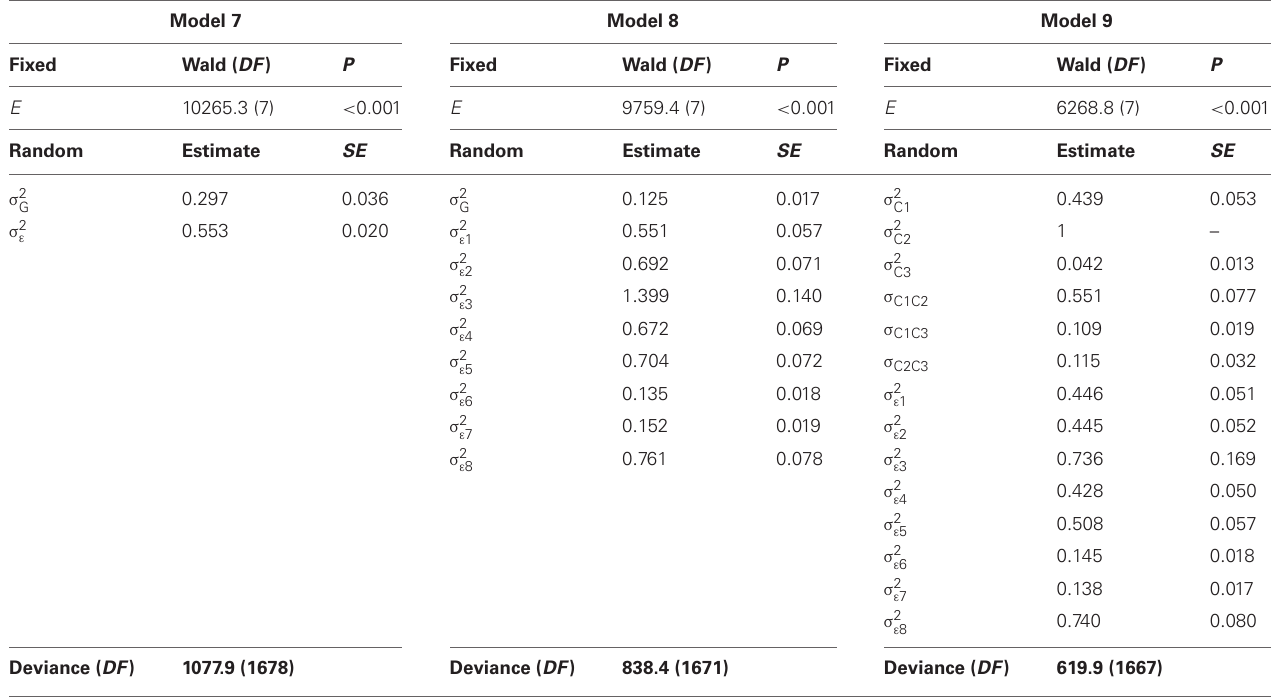
Model 7 assumes compoundsymmetry, model 8: assumes heterogeneityof geneticvariance across environments,and model 9 assumes heterogeneityof genetic covariance between groups of environments and heterogeneity of genetic variance across individual environments. Environments are indexed as: 1 = SS92a, 2